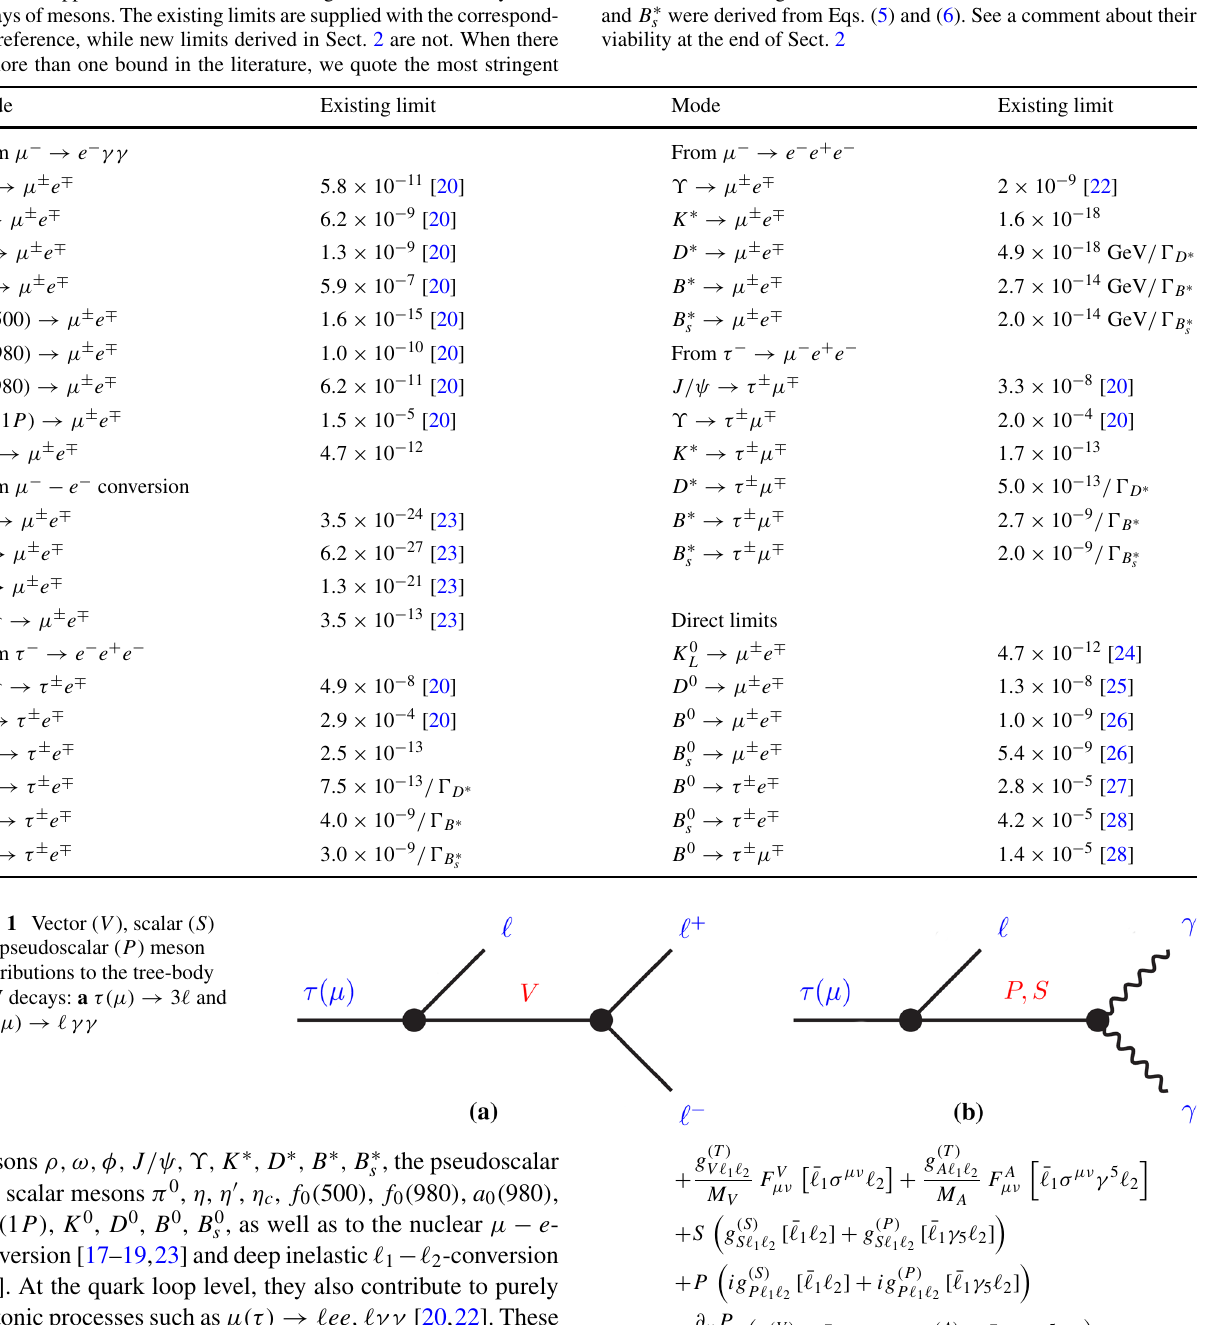
Table 1 Upper bounds for the branching ratios of two-body LFV decays of mesons. The existing limits are supplied with the correspond- ing reference, while new limits derived in Sect. 2 are not. When there is more than one bound in the literature, we quote the most stringent